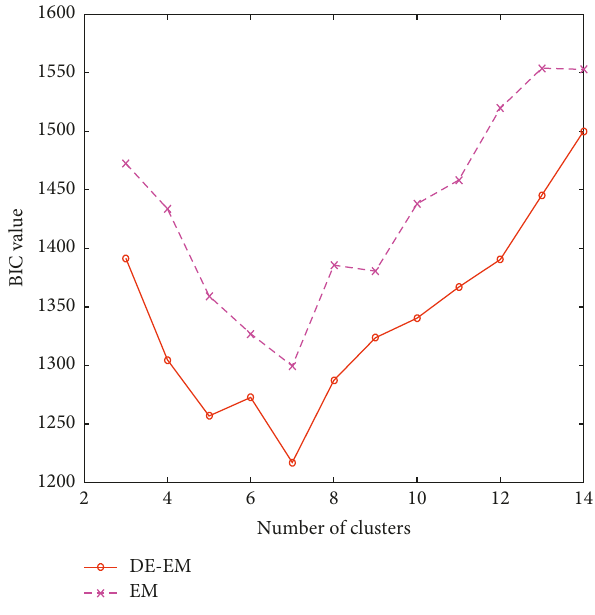
Figure 5: BIC value with different clusters.